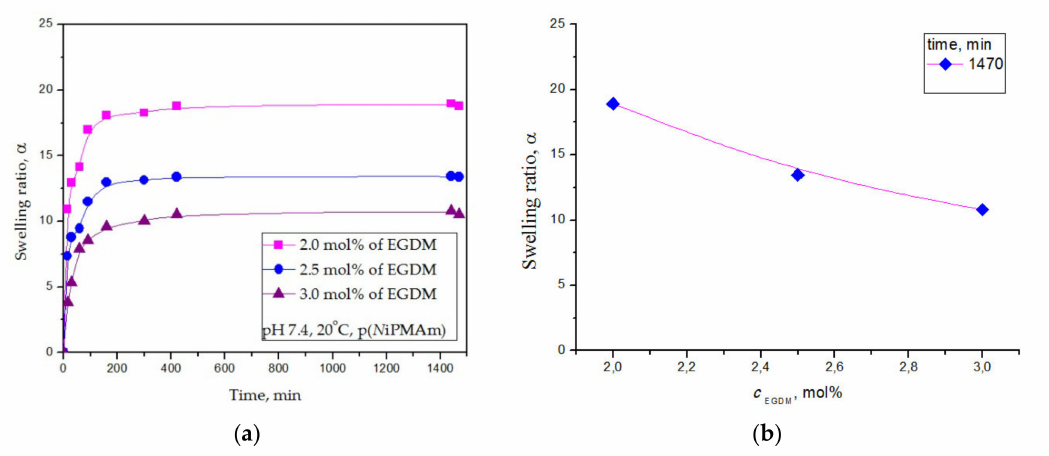
Figure 6. Swelling ratio, α , of the poly( N -isopropylmethacrylamide) hydrogels at 20 ◦ C and pH = 7.4 depending on: ( a ) time and ( b ) EGDM